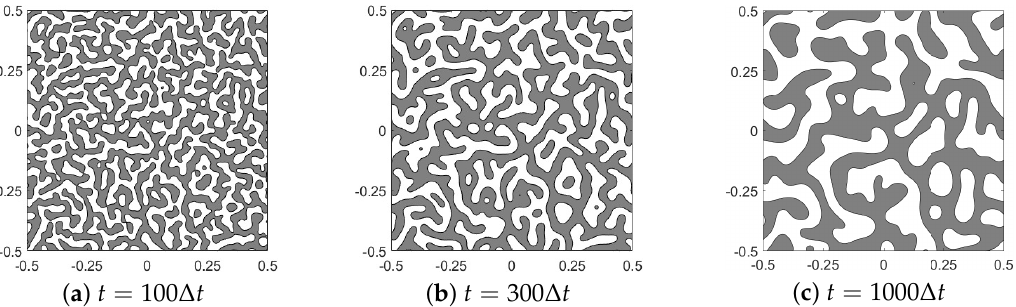
Figure 23. ( a – c ) are the snapshots of numerical solutions of the CH equation with the logarithmic Flory–Huggins free energy (55) and the initial condition (40) at t = 100 ∆ t , 300 ∆ t , and 1000 ∆ t ,